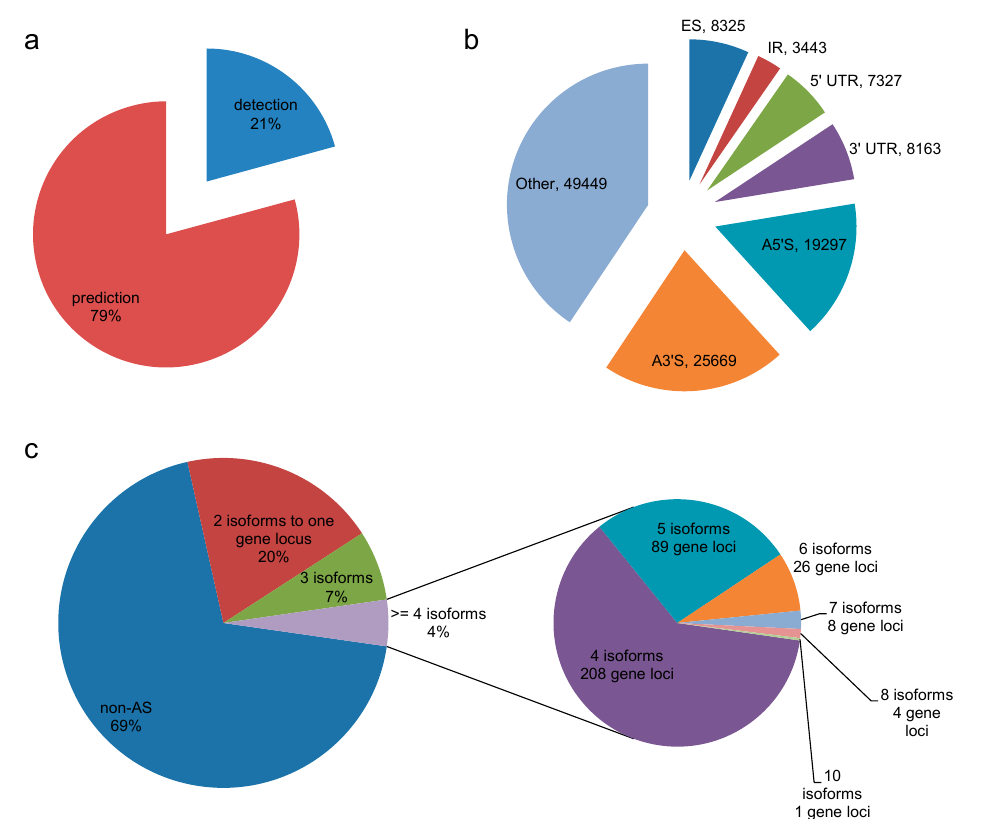
Figure 6. Detection and prediction of D. officinale gene isoforms using isoform detection and prediction (IDP). ( a ) Venn diagram to show the detection and prediction of 2680 and 10,230 isoforms, respectively; ( b ) Pie chart to show different alternatively spliced types. ES: exon skipping; IR: intron retention; A3’S: alternative 3’ splice site; A5’S: alternative 5’ splice site; ( c ) The distribution of alternatively spliced isoforms from each gene locus.